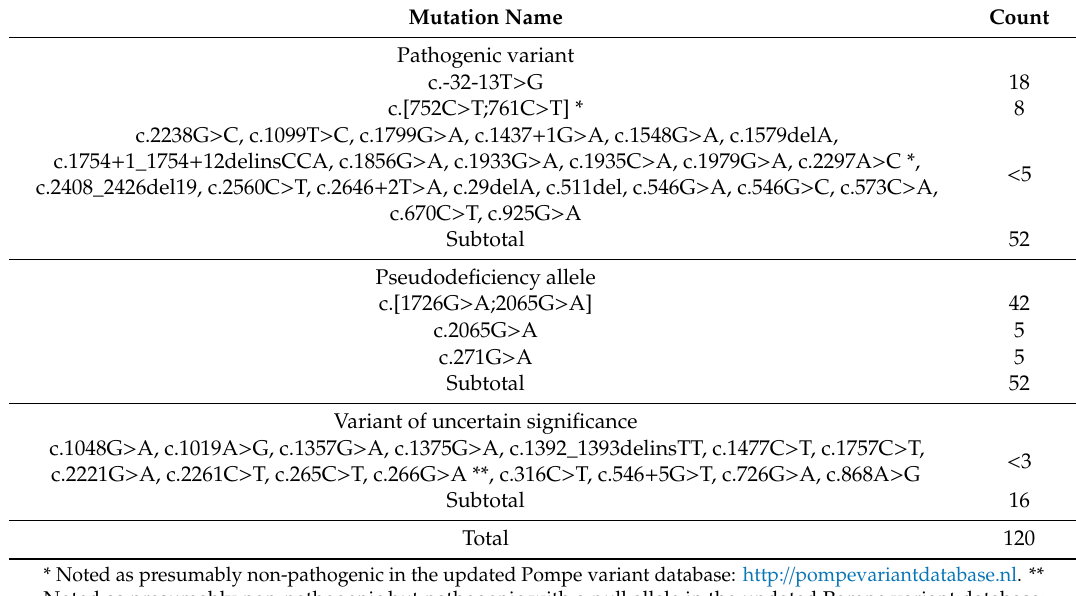
Table 3. Pompe disease variants identified by California newborn screening.